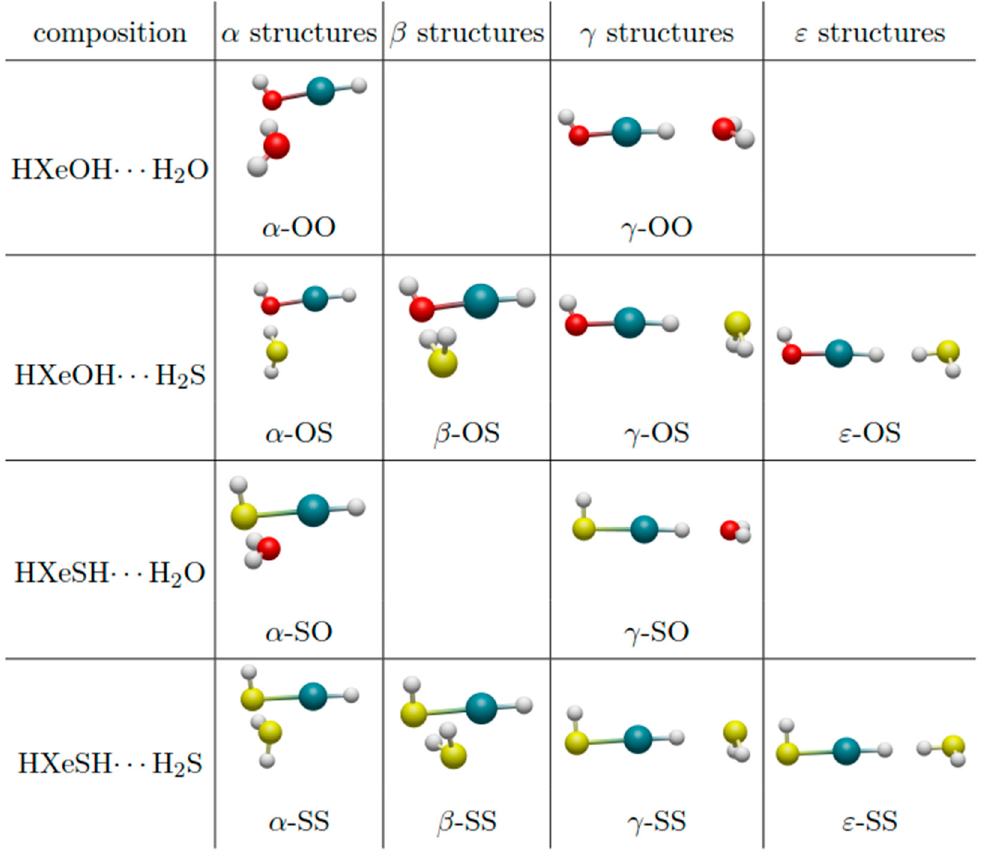
Figure 1. The calculated structures of the complexes of HXeOH and HXeSH with H 2 O and H 2 S. The atoms of hydrogen, oxygen, sulfur and xenon are marked with white, red, yellow and blue, respectively.